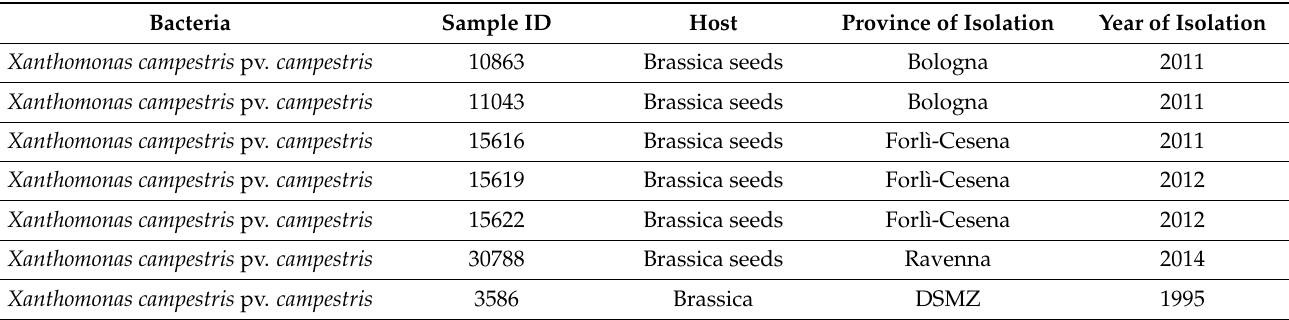
Table 2. X. campestris pv. campestris bacterial